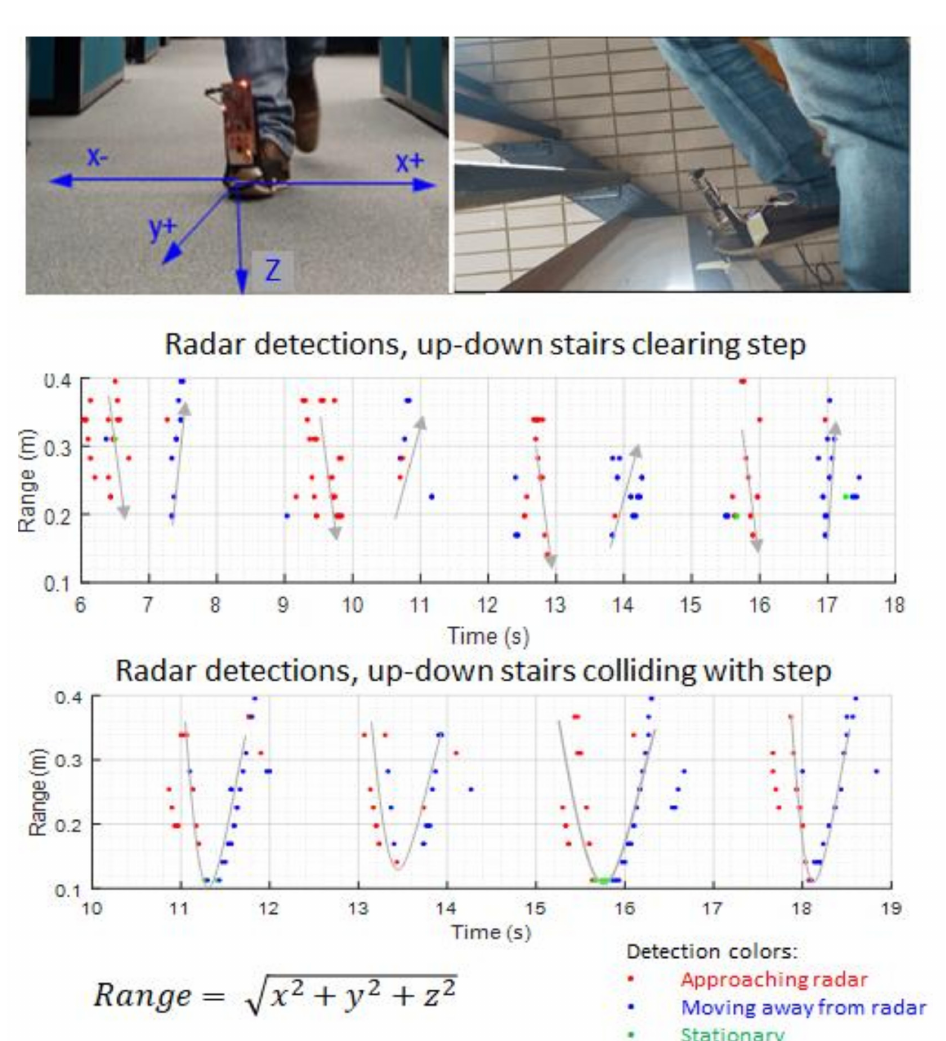
Figure 10. Experimental results. The radar was able to detect the staircase steps at a distance between 10 cm and 40 cm with the foot in movement towards and away from it. The points represent radar detections, and the colours represent direction of the Doppler speed estimation. Gray curves have been superimposed on the detection to highlight the difference in trajectories when the foot clears or collides with the